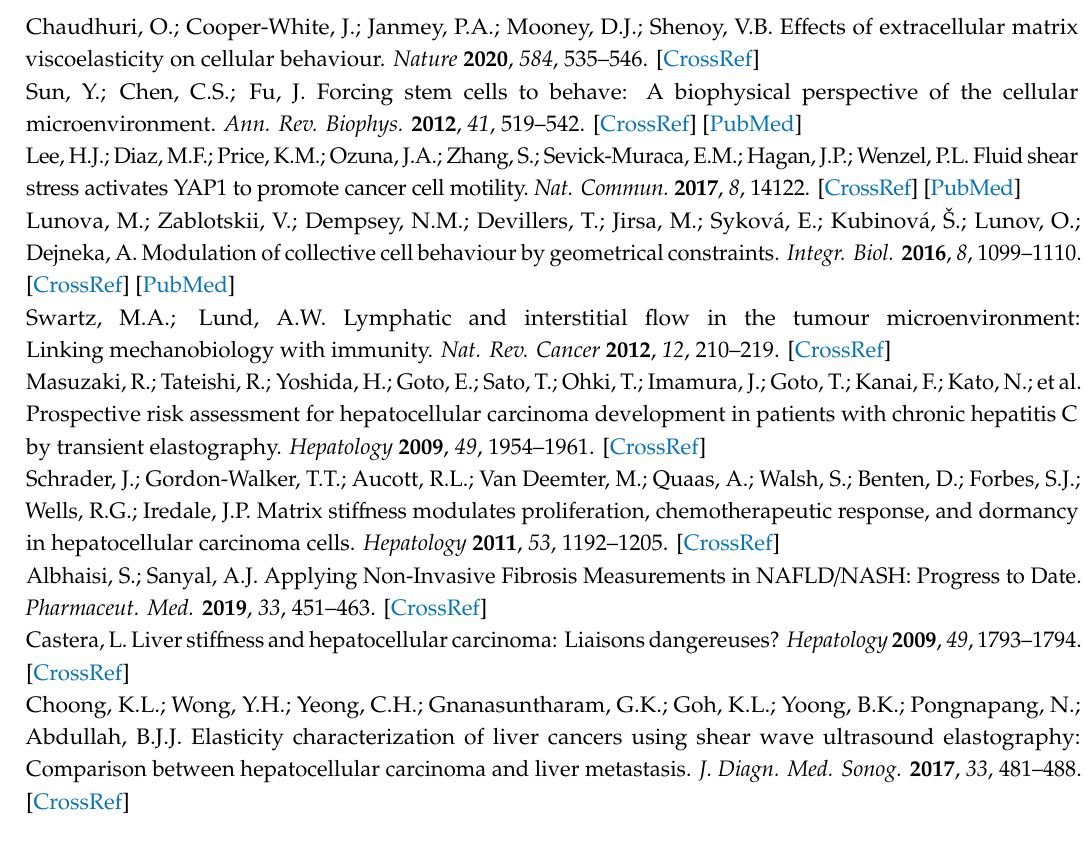
Figure S1: Analysis of the di ff usivity of Alexa 647, Alexa 488-dextrans and liposomes labeled with Bodipy-lipid analog in collagen sca ff olds assessed by Fluorescence Correlation Spectroscopy (FCS); Figure S2: Hepatic cell size and plasticity under culturing in collagen sca ff olds confocal analysis; Figure S3: Analysis of ethanol toxicosis of cells grown in collagen sca ff olds; Figure S4: Immunofluorescence confocal microscopy of Ki-67-stained HepG2 and Alexander cells; Figure S5: 3D reconstruction of cytoskeleton remodeling under culturing in collagen sca ff olds; Figure S6: Maximum intensity projections of cytoskeleton remodeling under culturing in collagen sca ff olds; Figure S7: Sub-cellular localization of YAP under culturing in collagen sca ff olds; Figure S8: Sub-cellular distribution of pmTOR upon YAP siRNA transfection. Table S1: List of chemical probes used in the study; Table S2: List of fluorescent probes used in the study; Table S3: List of antibodies used in the study; Uncropped immunoblot scans. Video S1: 3D reconstruction of Alexander cells grown in collagen sca ff olds; cell membranes were labeled with CellMask ™ Green (green). Hoechst 33342 (blue) dye was used to counterstain nuclei. Labeled cells were then imaged by confocal microscopy; Video S2: 3D reconstruction of HepG2 cells grown in collagen sca ff olds; cell membranes were labeled with CellMask ™ Green (green). Hoechst 33342 (blue) dye was used to counterstain nuclei. Labeled cells were then imaged by confocal